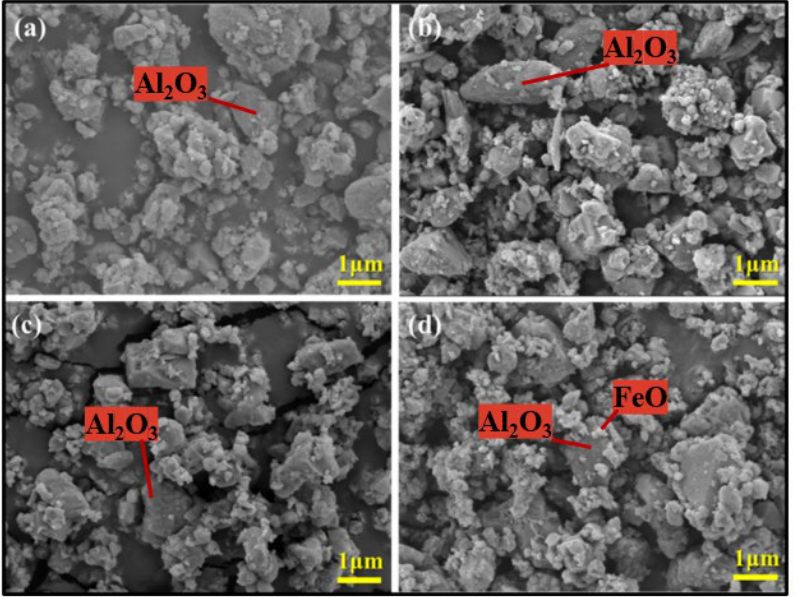
Figure 6. The greater enlargement SEM images of samples with different electrolysis temperatures, 800 °C in ( a ), 850 °C in ( b ), 900 °C in ( c ) and 950 °C in ( d ).